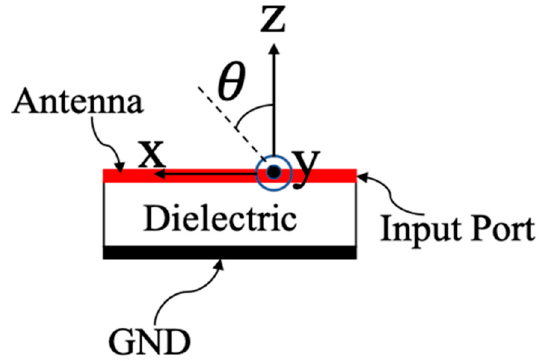
Figure 4. The radiation angle of CRLH TL.